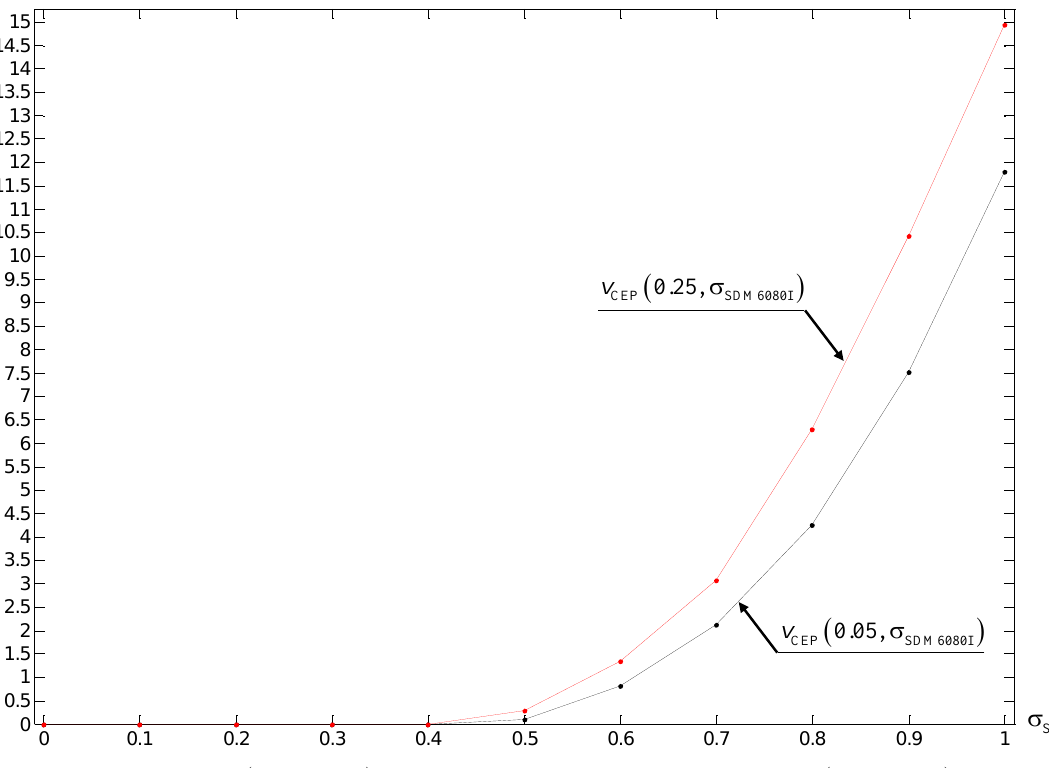
0.05, v  for 4800-240-26-PO and evaluation of the function   SDM6080I